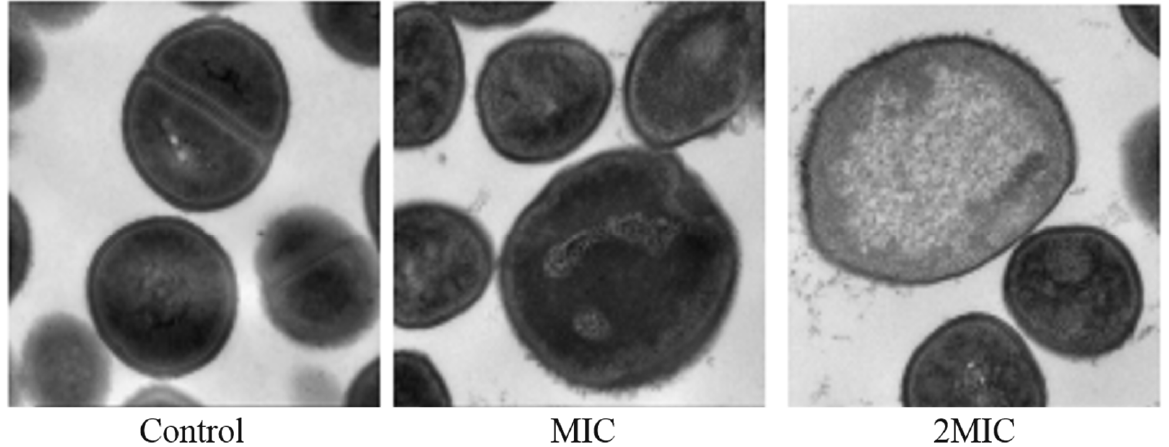
Figure 9. TEM images of S. aureus after treatment with MA. 2.8. Effect of MA on the Determination of Malate Dehydrogenase (MDH) and Succinate Dehydrogenase (SDH)